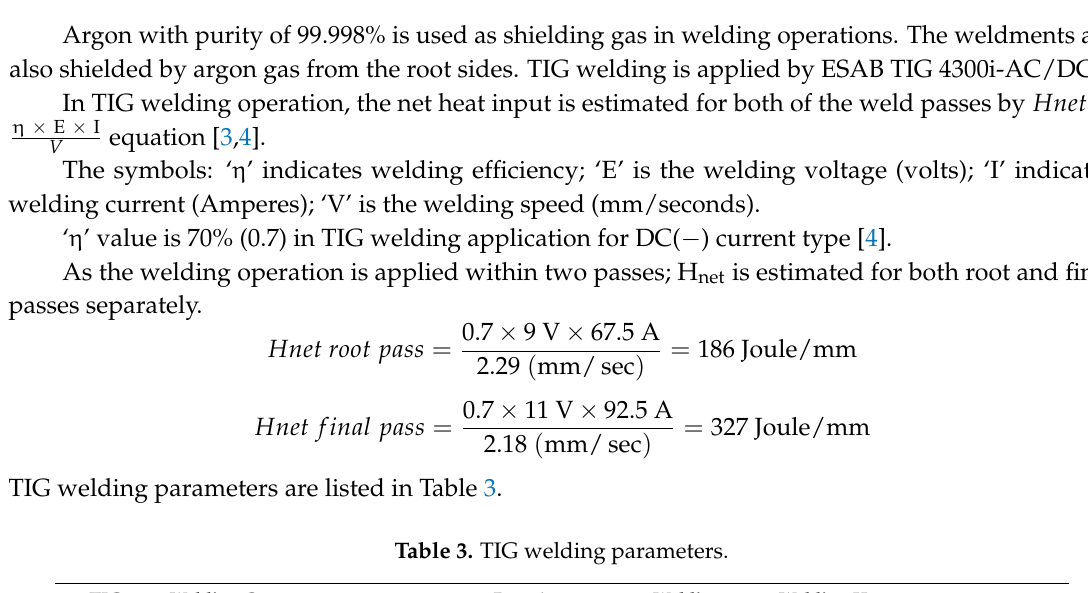
Figure 1. The dimensions of specimen couples for welding (mm).